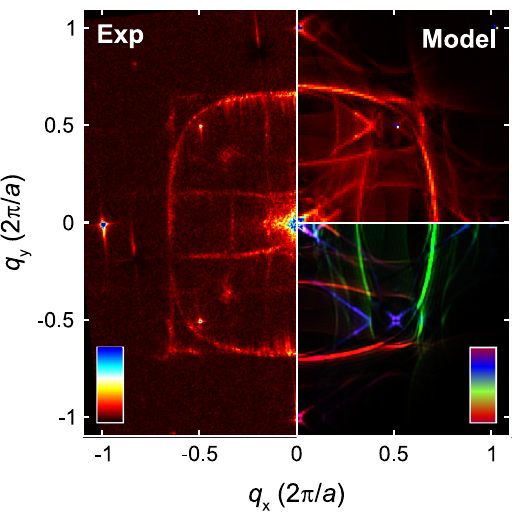
Fig. 5 Quasi-particle interference. Comparison of an experimental QPI map on the left ( V set = 5.8 mV, I set = 200 pA, T = 600 mK, B = 12 T, aliased Fourier peaks have been suppressed for clarity) with the theoretically calculated QPI map on the top right obtained from Fourier transformation of the real-space cLDOS at 2 meV, averaging over scattering patterns from both types of Ru impurities (see Suppl. Fig. 4 for real-space patterns close to individual Ru-site defects, V imp = + 0.1 eV, z = 5 Å ). The bottom right panel shows the orbital decomposition for the cLDOS calculations with red representing d yz - , green d xz -, and blue d xy